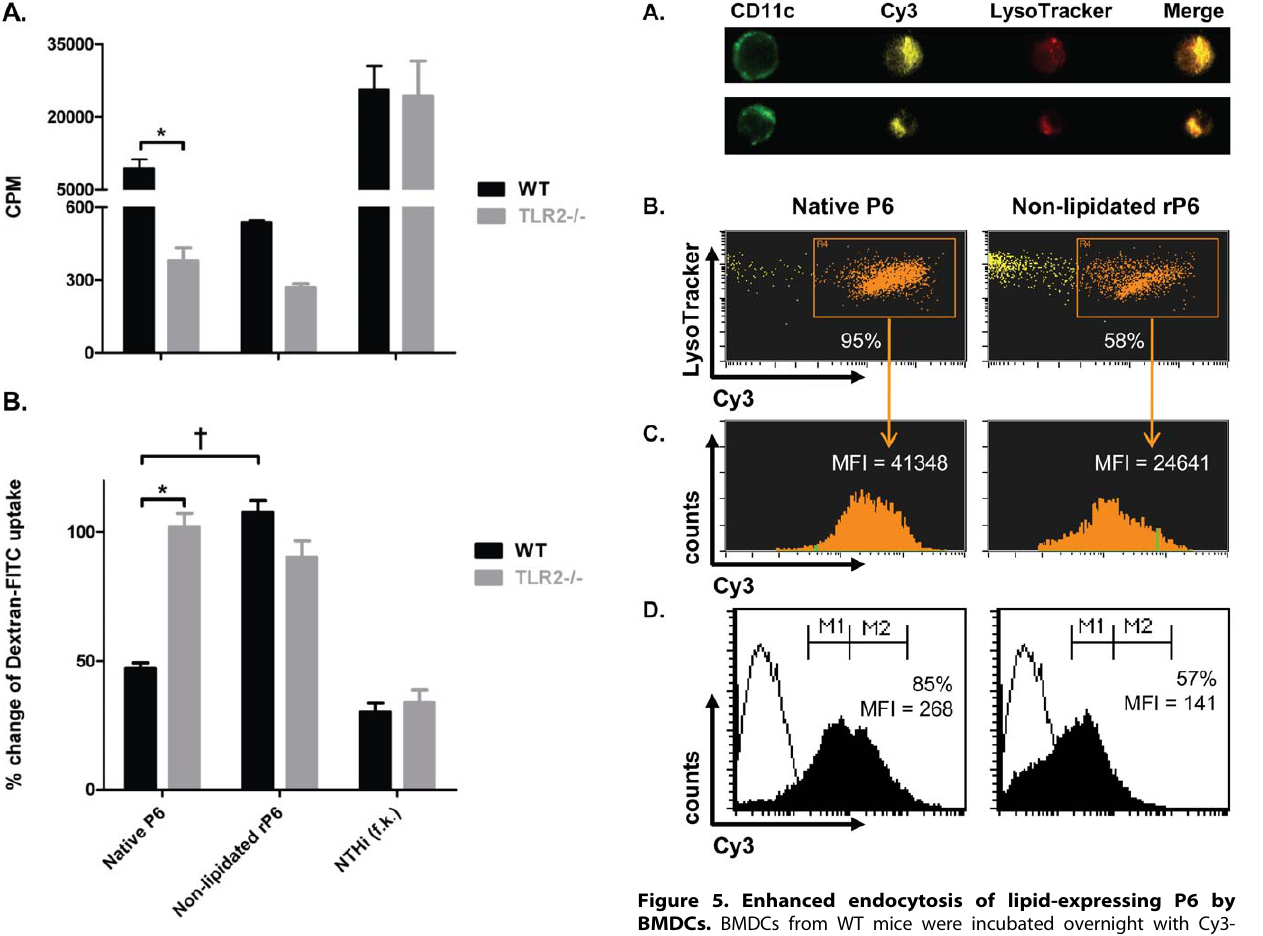
Figure 4. Expression of TLR2 on APCs mediates responses to lipoprotein P6. WT mice were immunized s.c. with 40 m g of native P6 emulsified in CFA and IFA one week later. ( A ) Proliferation of CD3 + cells isolated from draining lymph nodes was measured following 4 day co- culture with syngeneic irradiated WT (black) and TLR2 2 / 2 (gray) BMDCs pulsed with 0.06 m g/ml native P6 or non-lipidated rP6. Thymidine was added to the wells for the last 16 hrs of incubation. ( B ) BMDCs from WT (black bar) and TLR2 2 / 2 (gray bar) mice were incubated for 1 hr with the indicated stimuli and Dextran-FITC simultaneously (formalin-killed NTHI, f.k.). Cells were harvested and stained with anti-CD11c PE and acquired by two-color flow cytometry (FITC vs PE) to determine endocytic uptake of Dextran-FITC. Results are expressed as percent